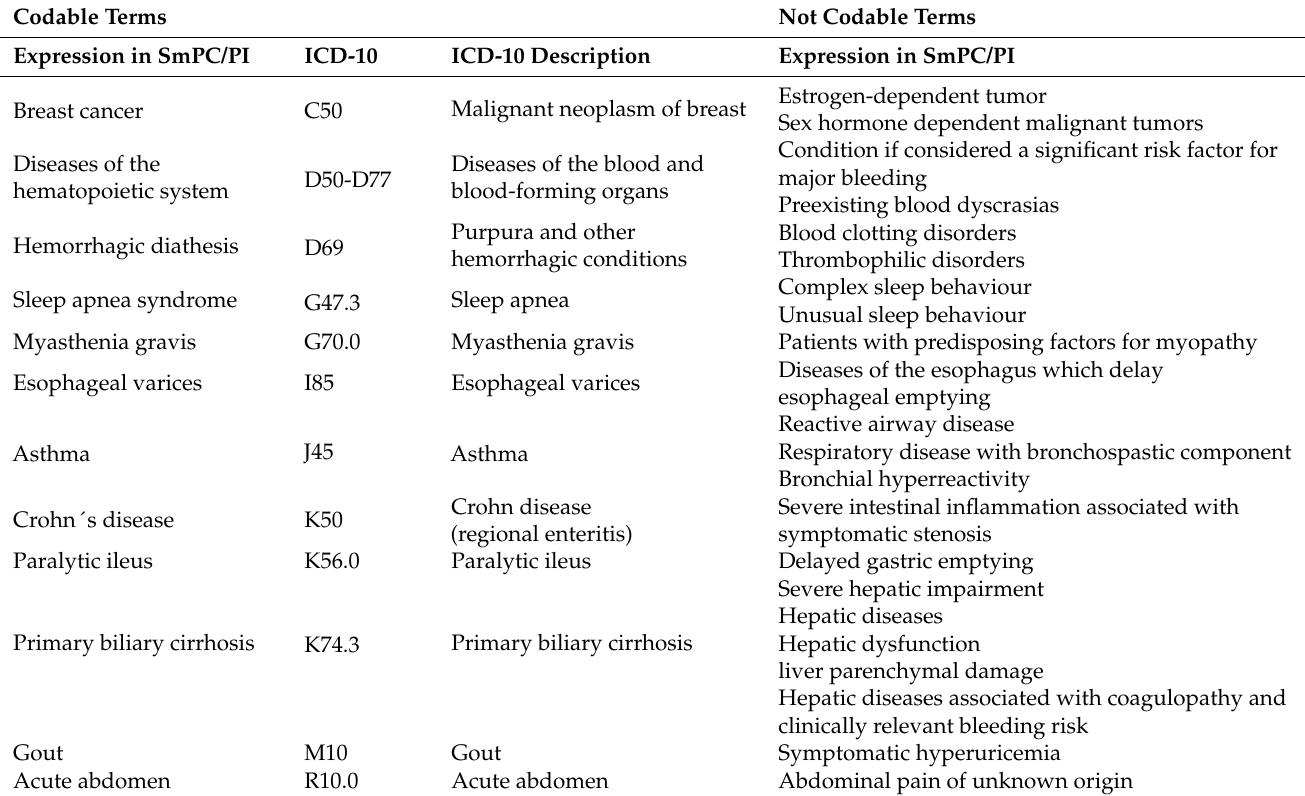
Table 2. Exemplary expressions in CIs: both codable expressions and their ICD-10 codability and thematically related not codable expressions are